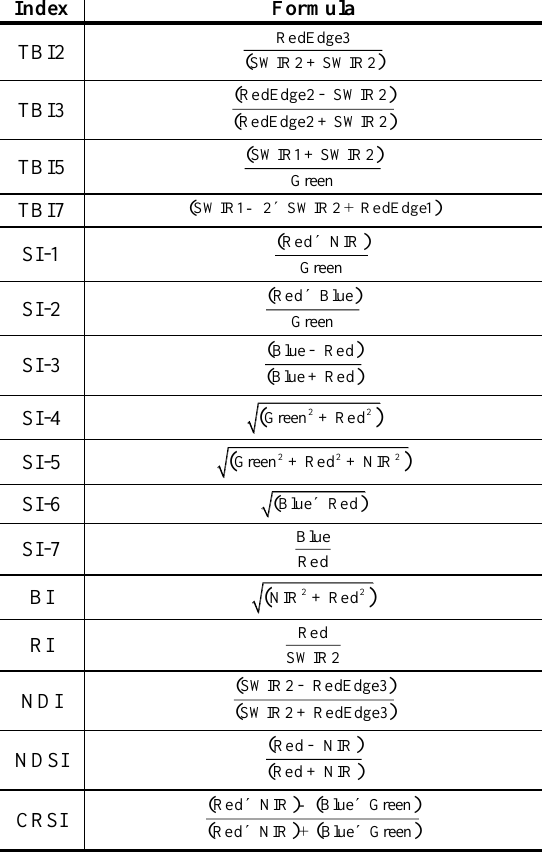
Table 4. Vegetation and salinity features were extracted from Sentinel-2 satellite data.